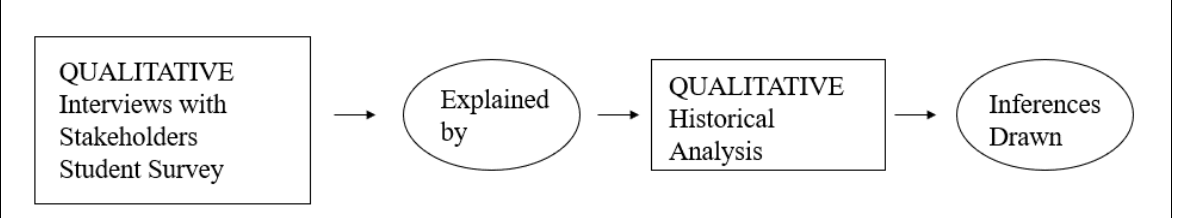
Figure 1. The Mixed-Methods Approach Utilized in this